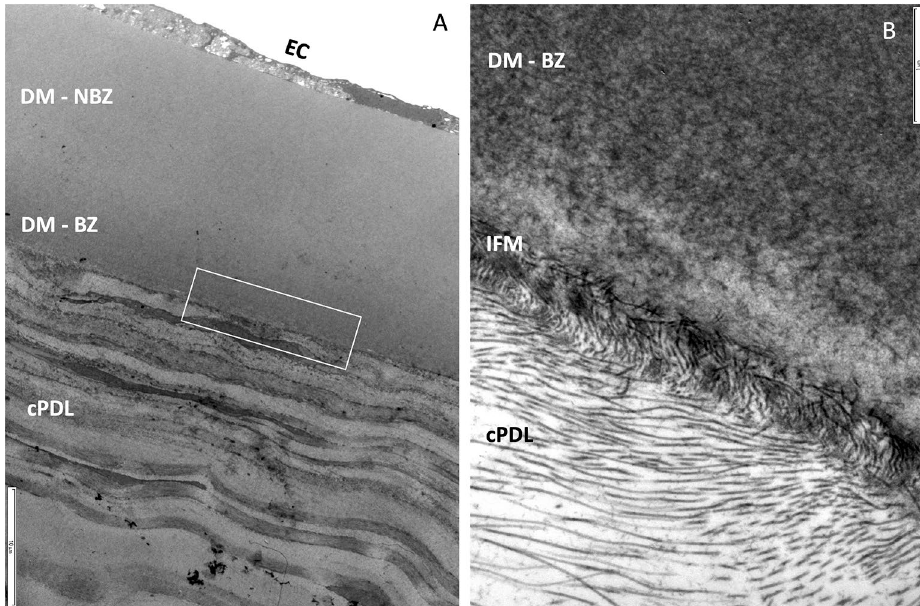
Figure 5. Histology of the interfacial matrix between the Descemet’s membrane (DM) and the canine pre-Descemet’s layer (cPDL). ( A ) Transmission electron microscopy (TEM) of the DM and the cPDL. The compacted alternating layers of the varying thickness of the cPDL are visible. (EC = endothelial cells. DM– NBZ = non-banded zone of the DM. DM–BZ = banded zone of the DM). The boxed area with the interfacial matrix is illustrated in high magnification in ‘B’. (Bar = 10 microns). ( B ) The interface between the DM and the cPDL is demonstrated. Fine fibrils are seen extending between the anterior surface of the PDL and the posterior surface of the banded zone of the DM (DM–BZ). Such fibrils are visible through most of the interfacial matrix (IFM) (Bar = 1 micron).